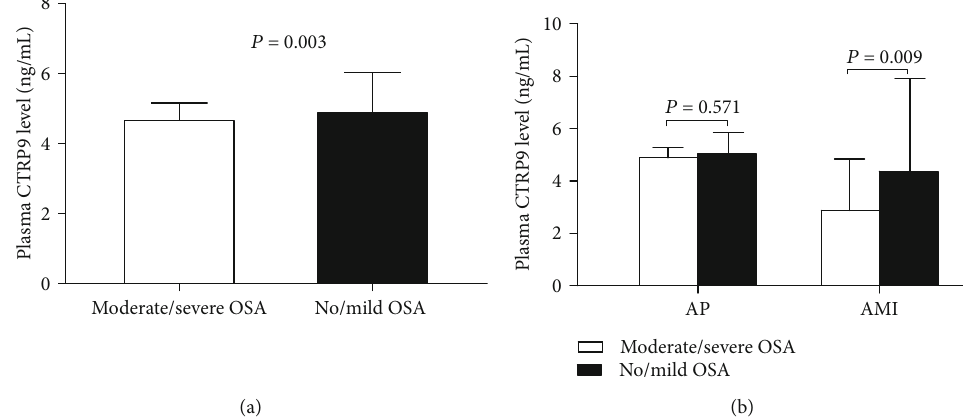
Figure 2: Plasma CTRP9 levels between moderate/severe OSA and no/mild OSA groups in patients with CAD (a). Plasma CTRP9 levels between moderate/severe OSA and no/mild OSA groups in AP and AMI subgroups (b). AMI: acute myocardial infarction; AP: angina pectoris; CTRP9: C1q/TNF-related protein 9; OSA: obstructive sleep